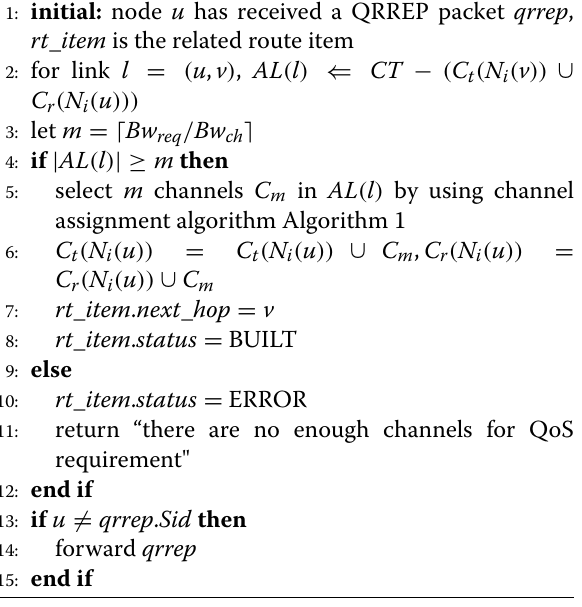
Algorithm 3 Process of node u receiving a QRREP packet from node v